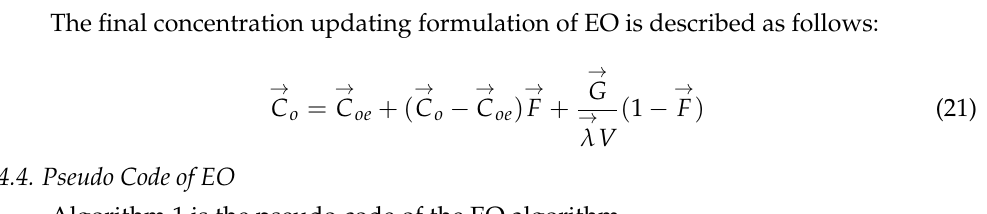
Algorithm 1 is the pseudo code of the EO algorithm. Algorithm 1: Equilibrium optimization algorithm.